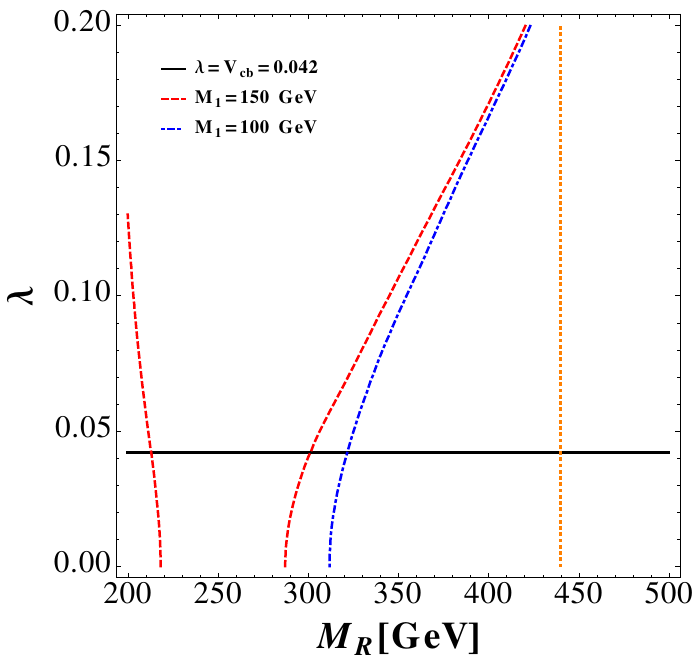
Figure 1 . 95% C.L. bounds in the λ - M R plane obtained using the result of the e ± e ± channel in table 3 of ref. [12]. For M = 150 GeV, the excluded region is between the two dashed red lines. For 1 M 1 = 100 GeV, the excluded region is to the left of the dot-dashed blue line. In this plot we also show the discovery region for M = 150 GeV, which lies to the left of the vertical dotted orange line 1 (see section 5). The black horizontal line represents our choice of λ = 0 . 042 . Note that the minimal value of λ in this figure is ∼ 10 − 3 such that the three body decay of the N is 1